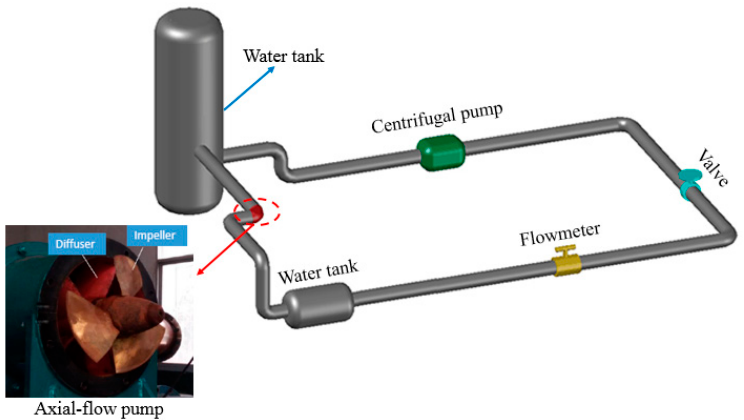
Figure 1. Axial-flow pump located at Wuhan University.